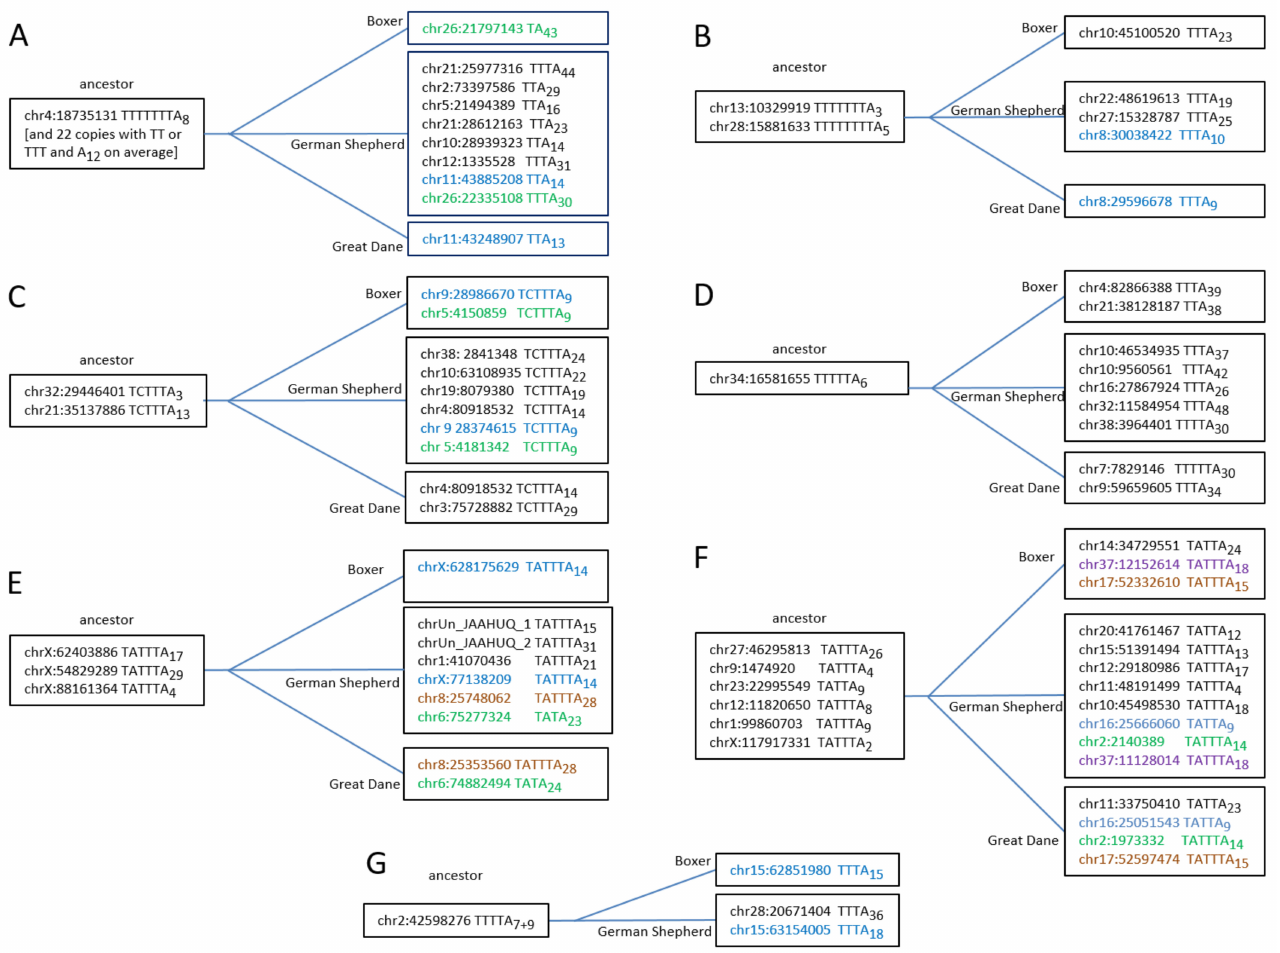
Figure 7. Examples of Can_b2 copies ( A – G ) illustrating their retrotransposition via T + mechanism. The left coordinate, terminator structure, and poly(A) tail length are specified. The left (“ancestor”) boxes include copies present in the genomes of the German Shepherd, Great Dane, and Boxer; the right boxes include daughter copies present in one or two dog breeds (copies found in two breeds are given in the same